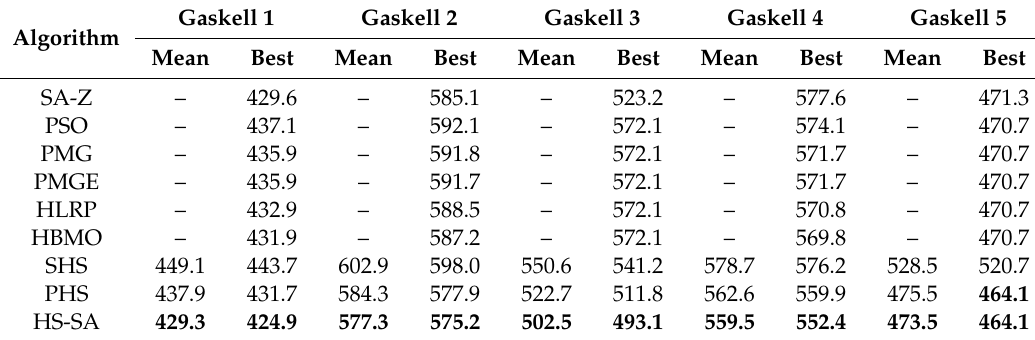
Table 4. Comparative results of Gaskell dataset for LRP.